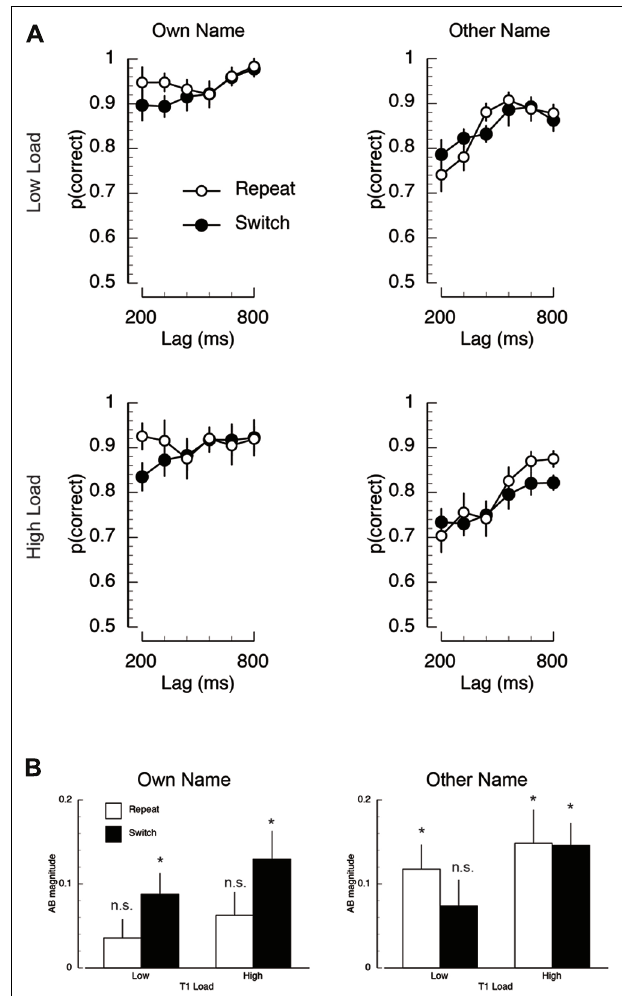
FIGURE 6 | Mean task 2 behavioral performance in Experiment 2 . (A) Mean proportion of correct responses on the second target (T2) task, plotted as a function ofT1 load (high/low),T2-name (own/other),T1–T2 lag (320/920 ms), and inter-trialT1-load dependency (repeat/switch). (B) Mean AB magnitude plotted as a function ofT2-name (own/other),T1 load, and inter-trialT1-load dependency. Asterisks indicate that AB magnitude was significantly different than zero at p < 0.05, FDR-corrected for multiple comparisons.